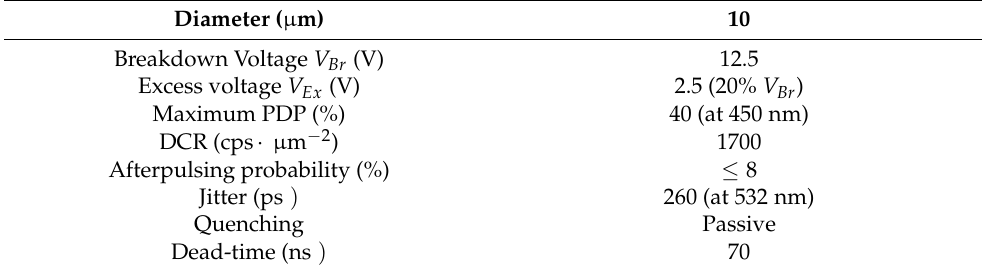
Table 1. SPAD performance parameters measured with an excess bias voltage of 2.5 V ( V Ex = 20% V Br